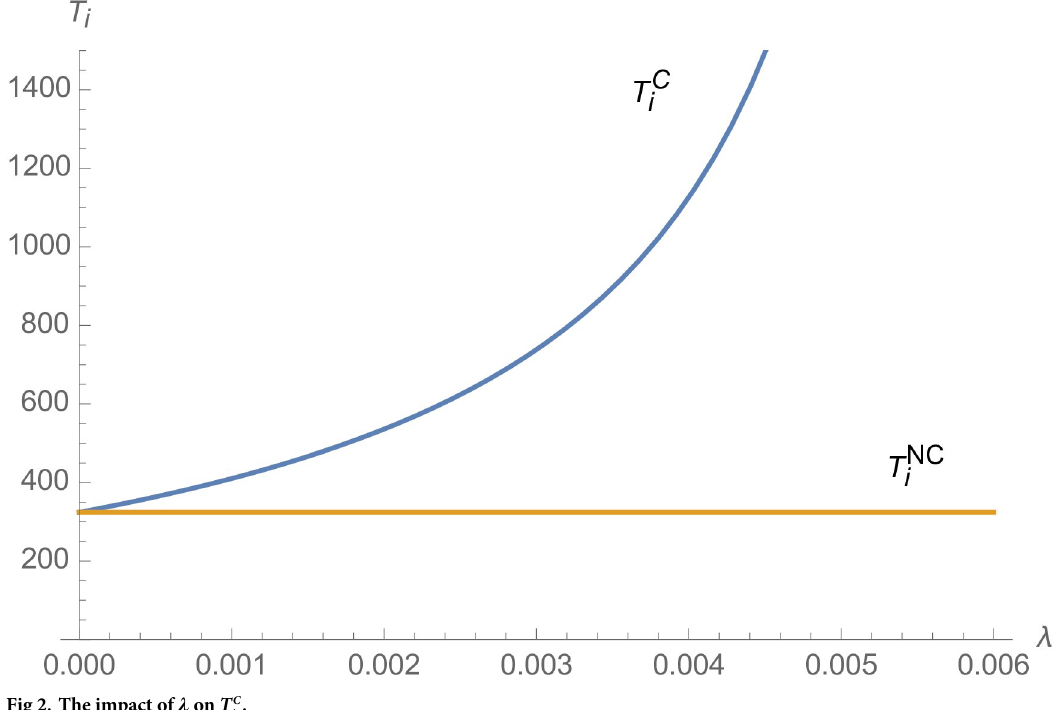
Fig 2. The impact of λ on T C